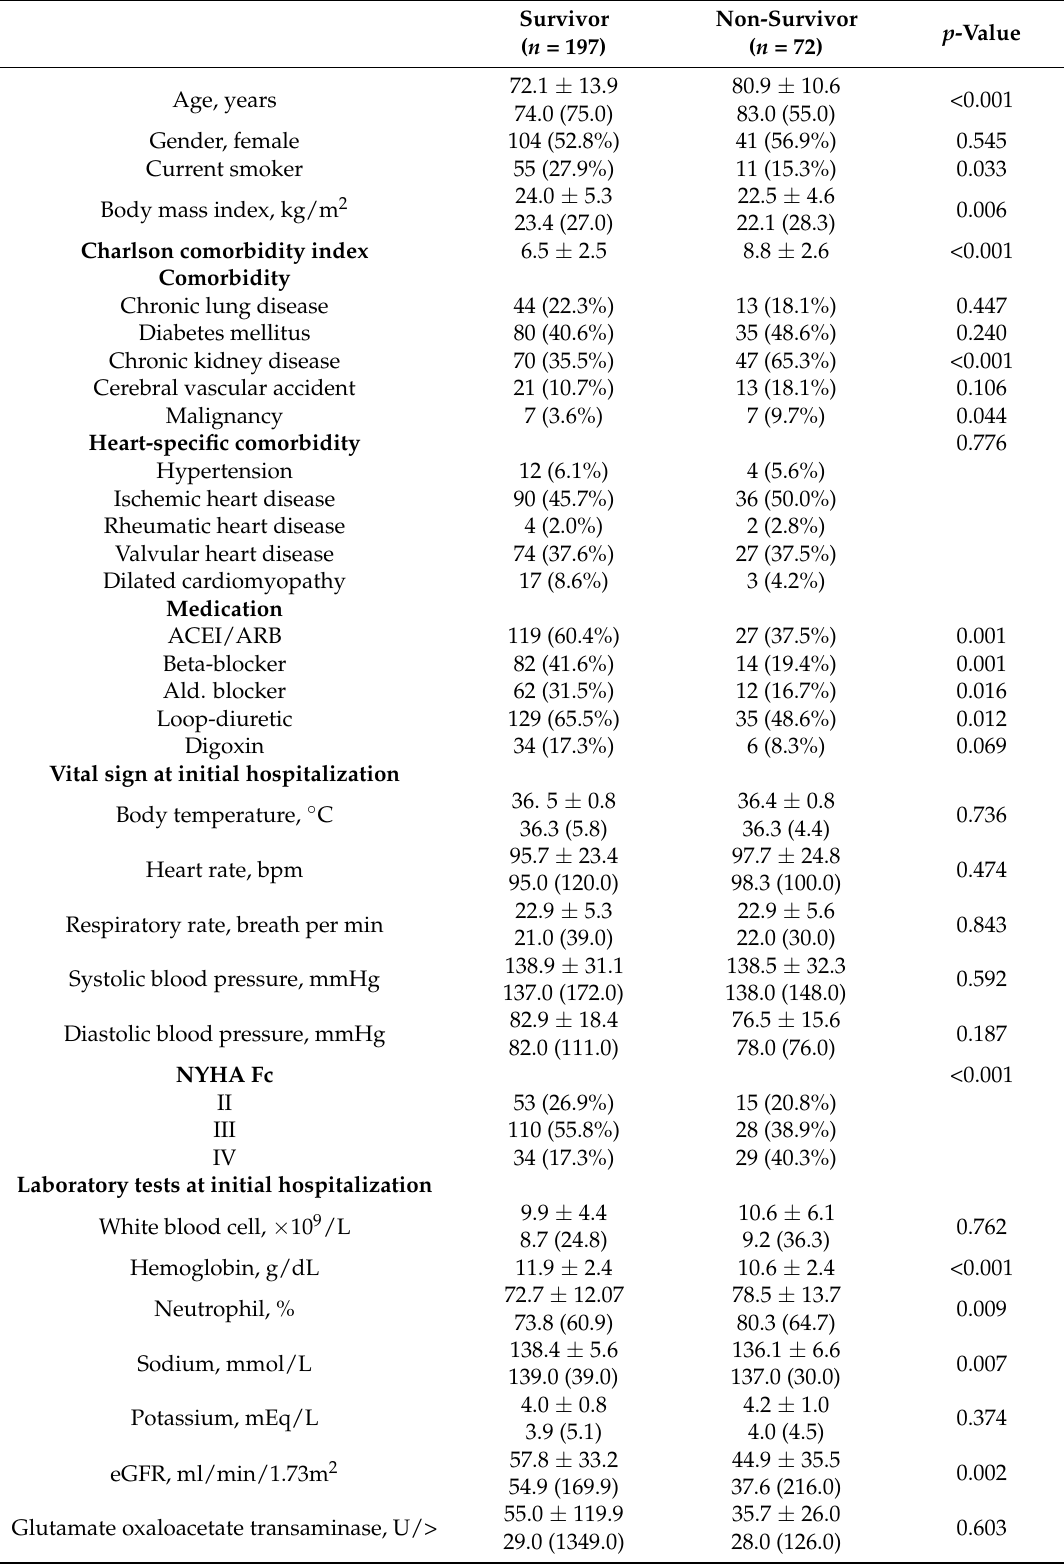
Table 1. Comparisons of basic characteristics and clinical variables between survivors and non-survivors after a 12-month